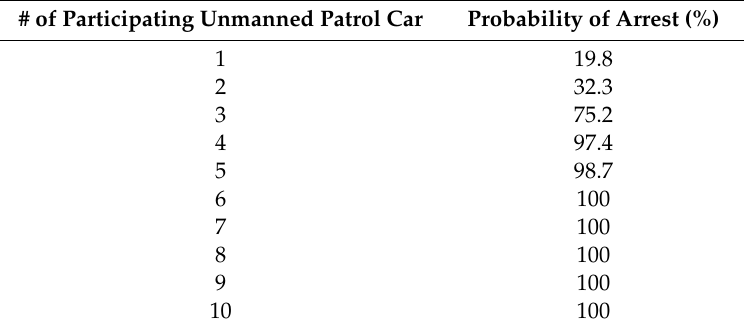
Table 2. Probability of arresting a criminal suspect according to the increase of unmanned patrol cars.